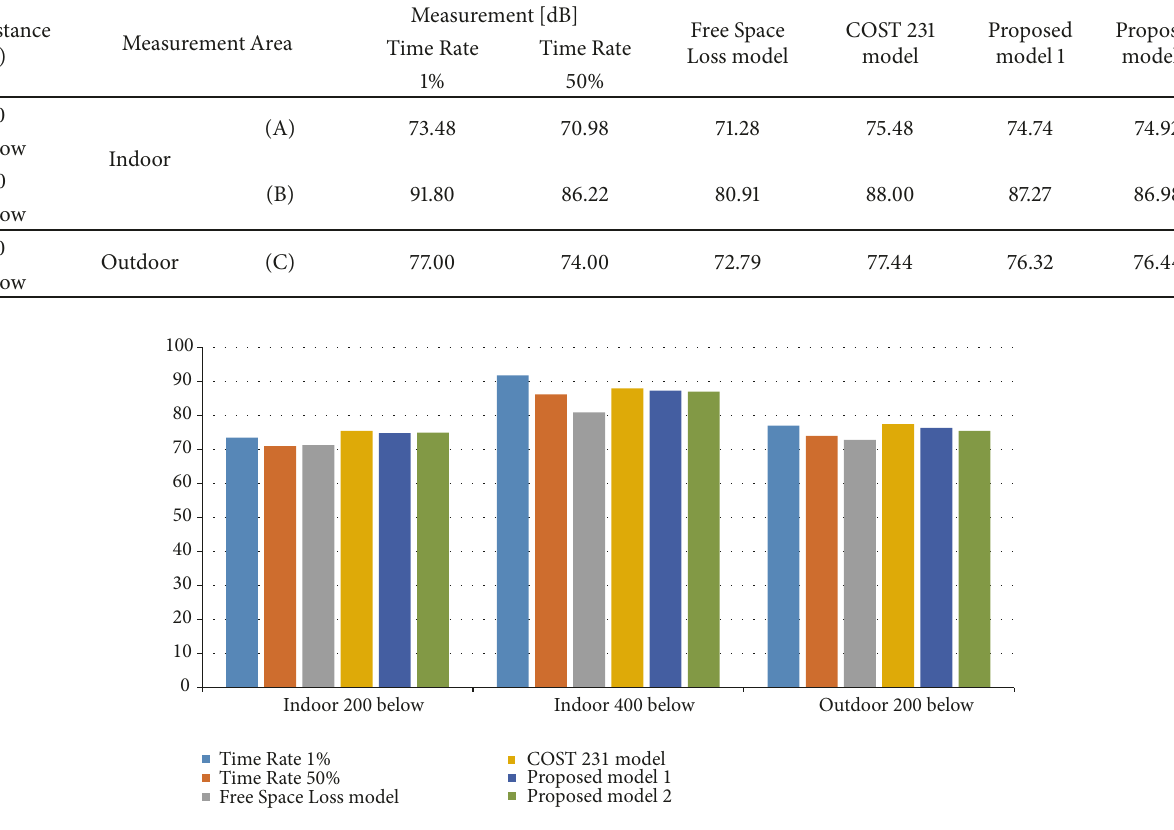
Figure 2: Comparison of time rates (1% and 50%) and proposed